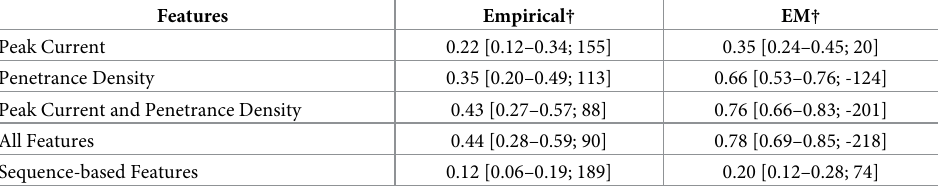
Table 1. Weighted R 2 from EM prior means to Empirical/EM posterior means. Models trained with displayed sub- sets of features using the same subset of variants, where covariates listed in S1 Table are